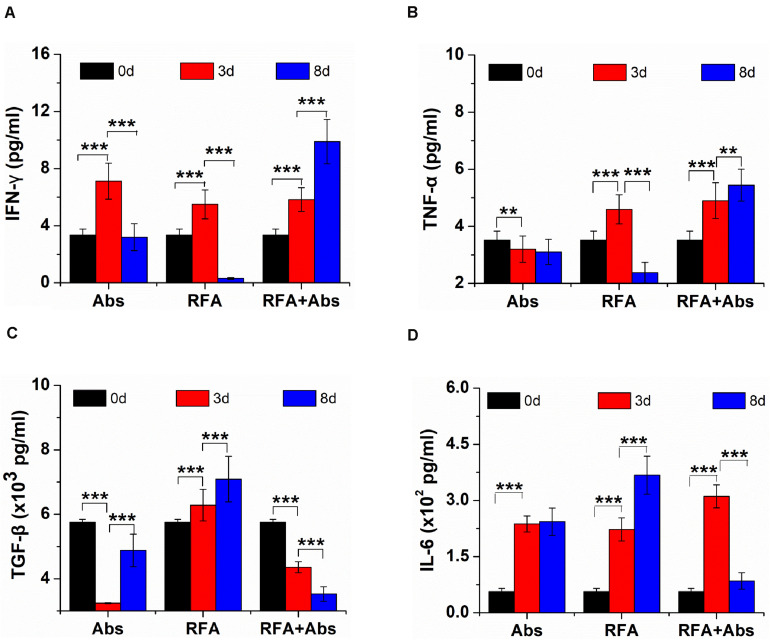
The ELISA assays were used to evaluate systemic immune responses by measuring the level of cytokine in vivo from different treatments (Abs, RFA, and Abs + RFA) at different time points (before RFA, 3 days after RFA, 8 days after RFA). (A) The ELISA assays of IFN-γ from different groups at different time points. (B) The ELISA assays of TNF-α from different groups at different time points. (C) The ELISA assays of TGF-β from different groups at different times. (D) The ELISA assays of IL-6 from different groups at different time points. ***P < 0.001, **P < 0.01.